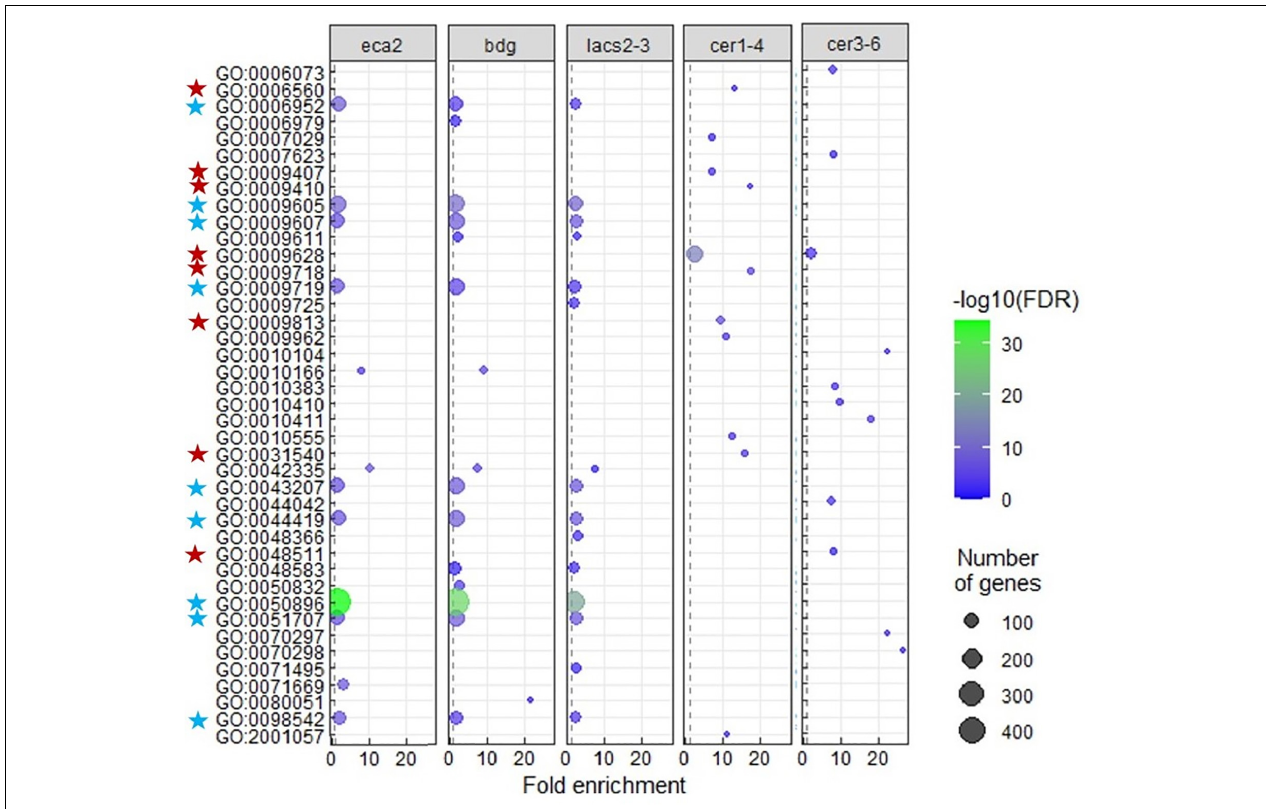
FIGURE 5 | Gene ontology (GO) enrichment among upregulated genes in each cutin or wax mutant. Terms that were largely redundant were removed. Enrichment of “Biological process” GO-terms (FDR < 0.01). The color of the circles indicates the significance of the term (–log FDR), and dot size indicates the number of genes that are associated with that term. The blue stars indicate the GO terms common and mainly related to response to biotic stress, and the red stars indicate the GO terms related to response to abiotic stress, in the cutin and wax mutants,